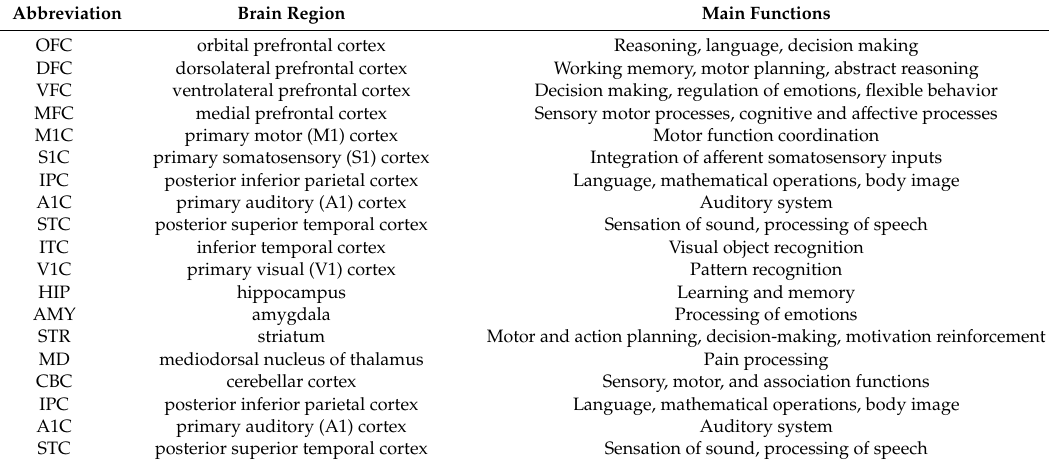
Table 1. Summary of the abbreviations used for the brain regions with their descriptions and main functions